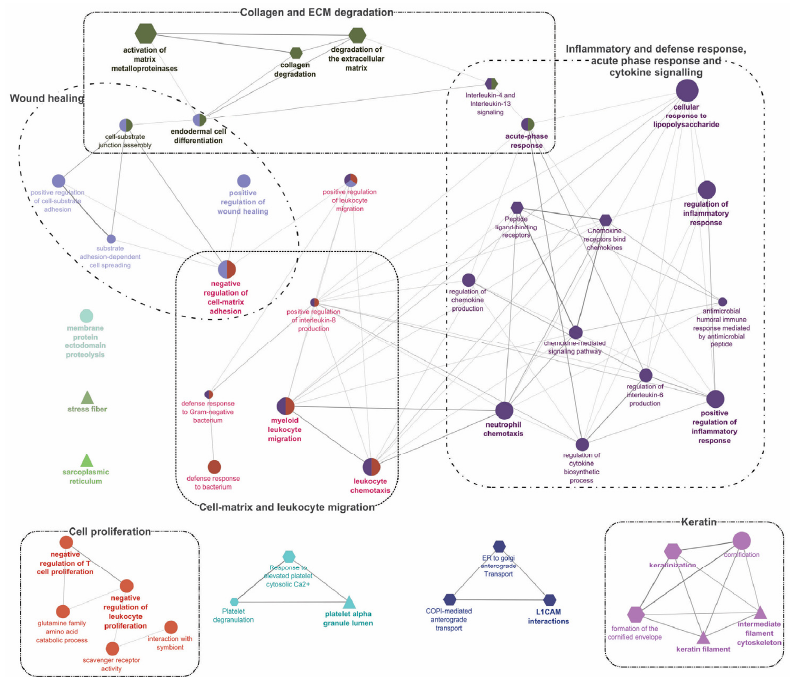
Figure 5. Gene-Ontology (GO) term enrichment and pathway term network analysis of DEGs in ATT versus ADJ list (90 DEPs). Refer to the caption of Figure 4 and Supplementary File S9 for additional details and the high-resolution image.